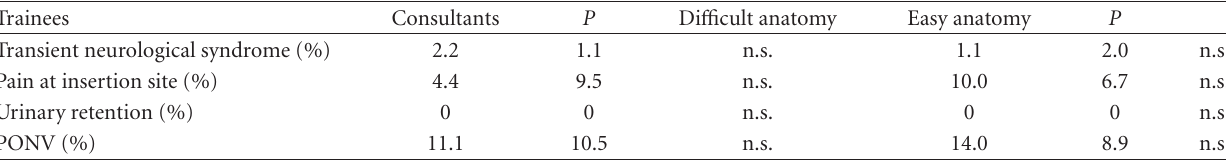
Table 3: Incidences of complications on day one postoperatively and respective operator experience.